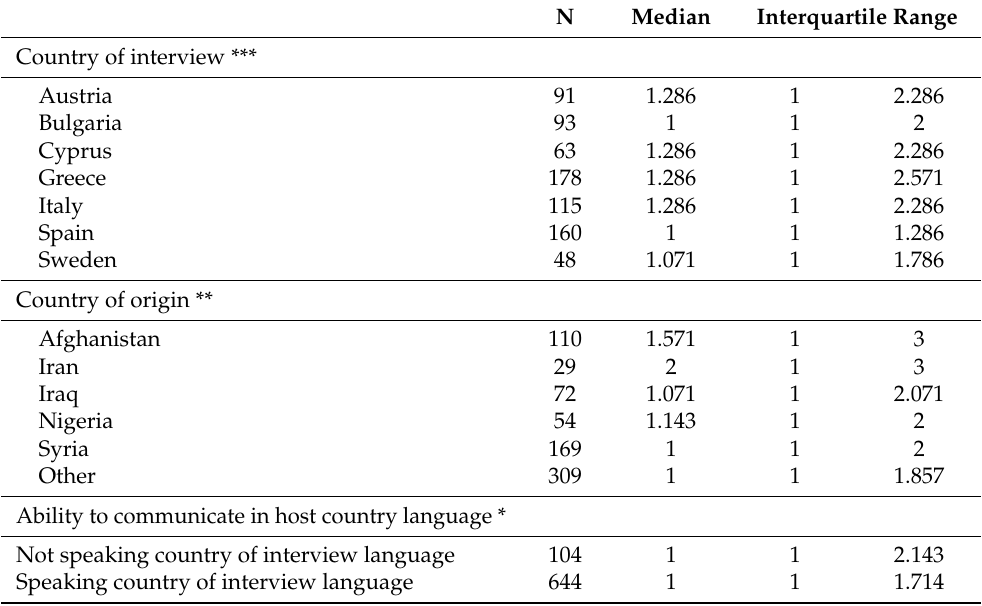
Table 2. Discrimination Scale to Medical Settings by country of interview, country of origin, and communication skills. Migrants and refugees from Germany, France, and Malta were excluded from the analysis.